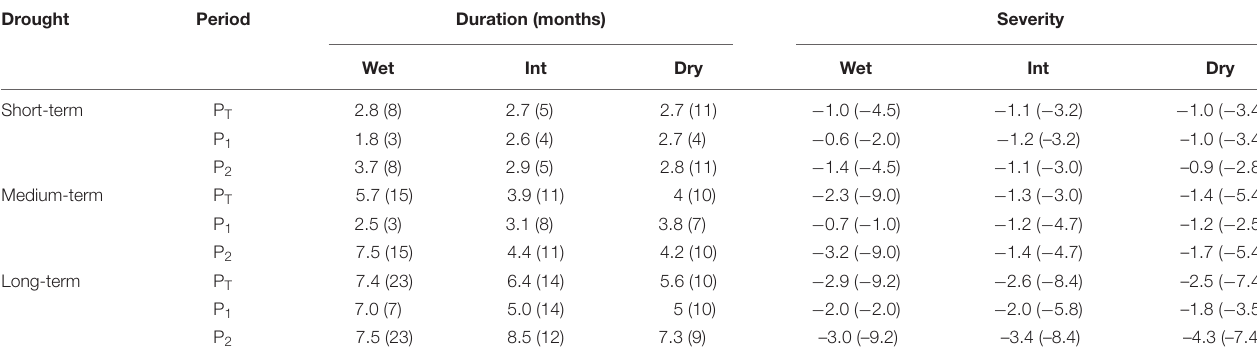
TABLE 3 | The average drought duration (months) and severity of short-term (SPEI-3 < − 1), medium-term (SPEI-6 < − 1), and long-term (SPEI-12 < − 1) droughts events over the wet, intermediate, and dry region in MRB for the early (P 1 ; 1985–1999), late (P 2 ; 2000–2015), and whole study (P T ; 1985–2015) periods. Drought Period Duration (months)